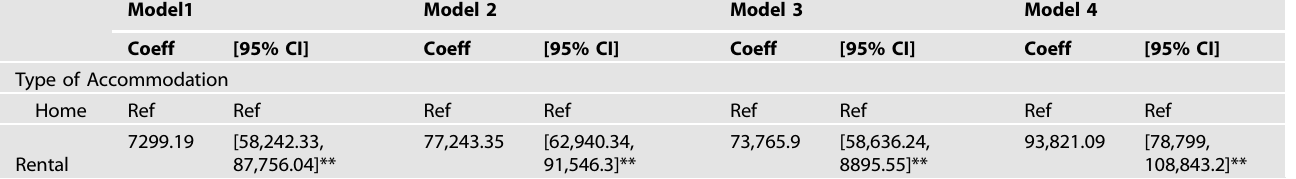
Model 2: Model 1 adjusted with household income; Model 3: Model 2 adjusted with hometown area; Model 4 adjusted household income, hometown area, year of education, and gender. Linear regression; ** p < 0.001. a Linear